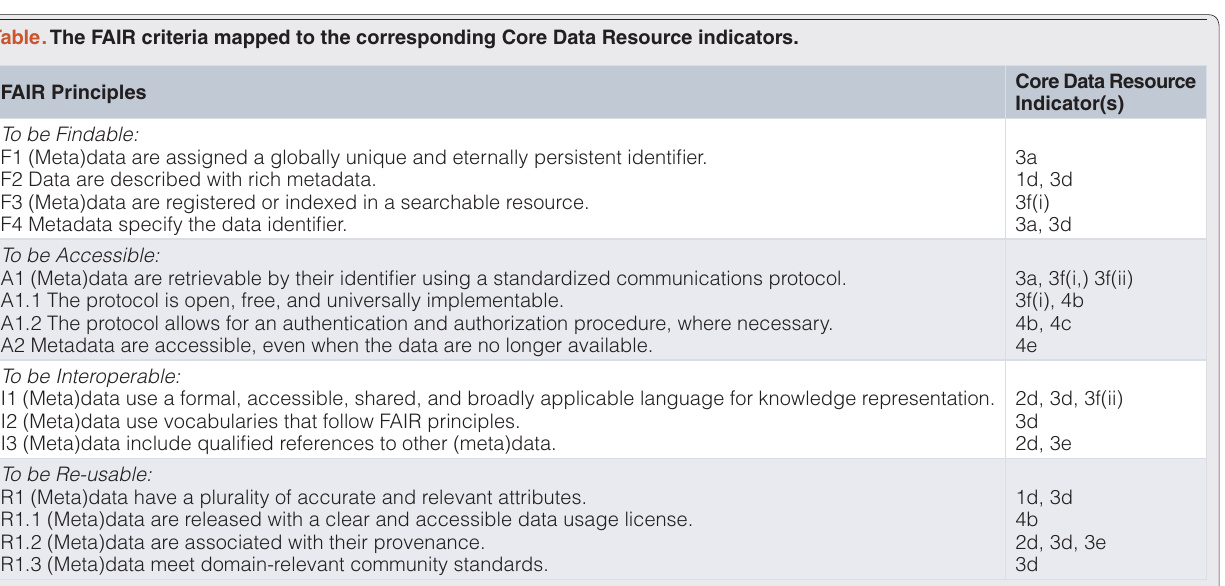
Table . The FAIR criteria mapped to the corresponding Core Data Resource indicators. FAIR Principles